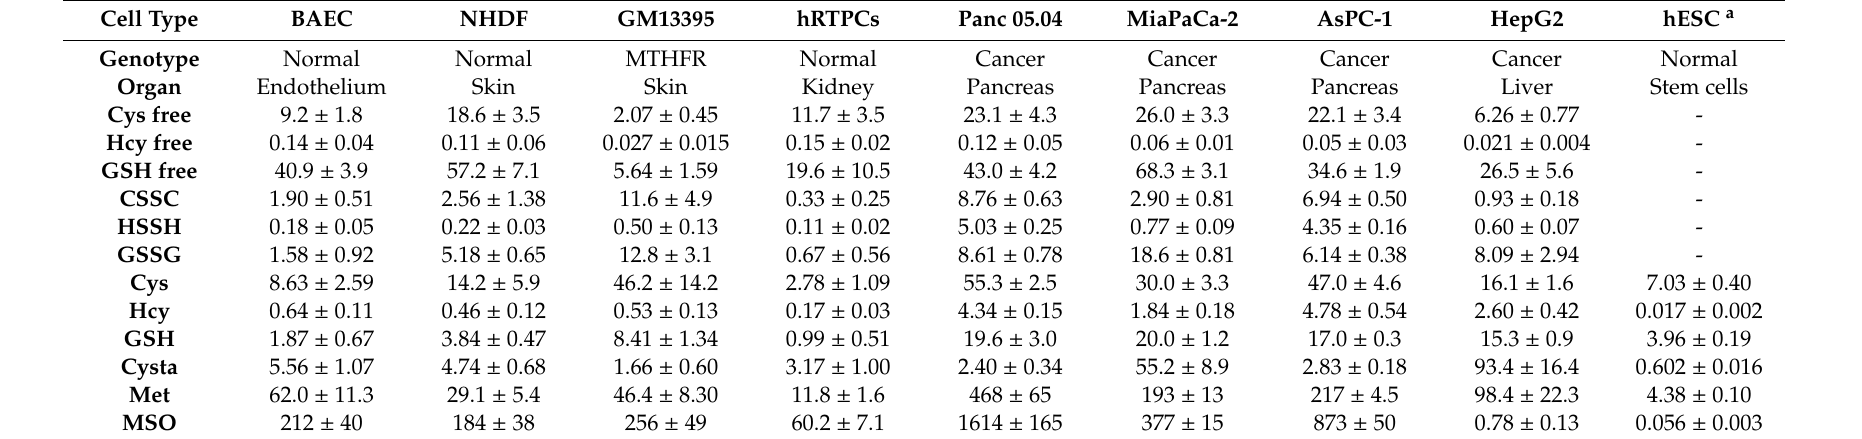
Table 6. Profile of thiol and thioether metabolites in several cell types (nmol / mg